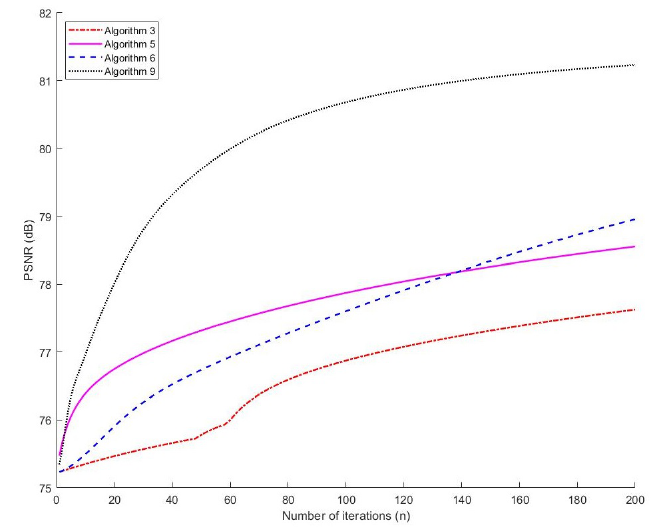
Figure 4. A graph of the PSNR of each algorithm at Iteration Number 1 to